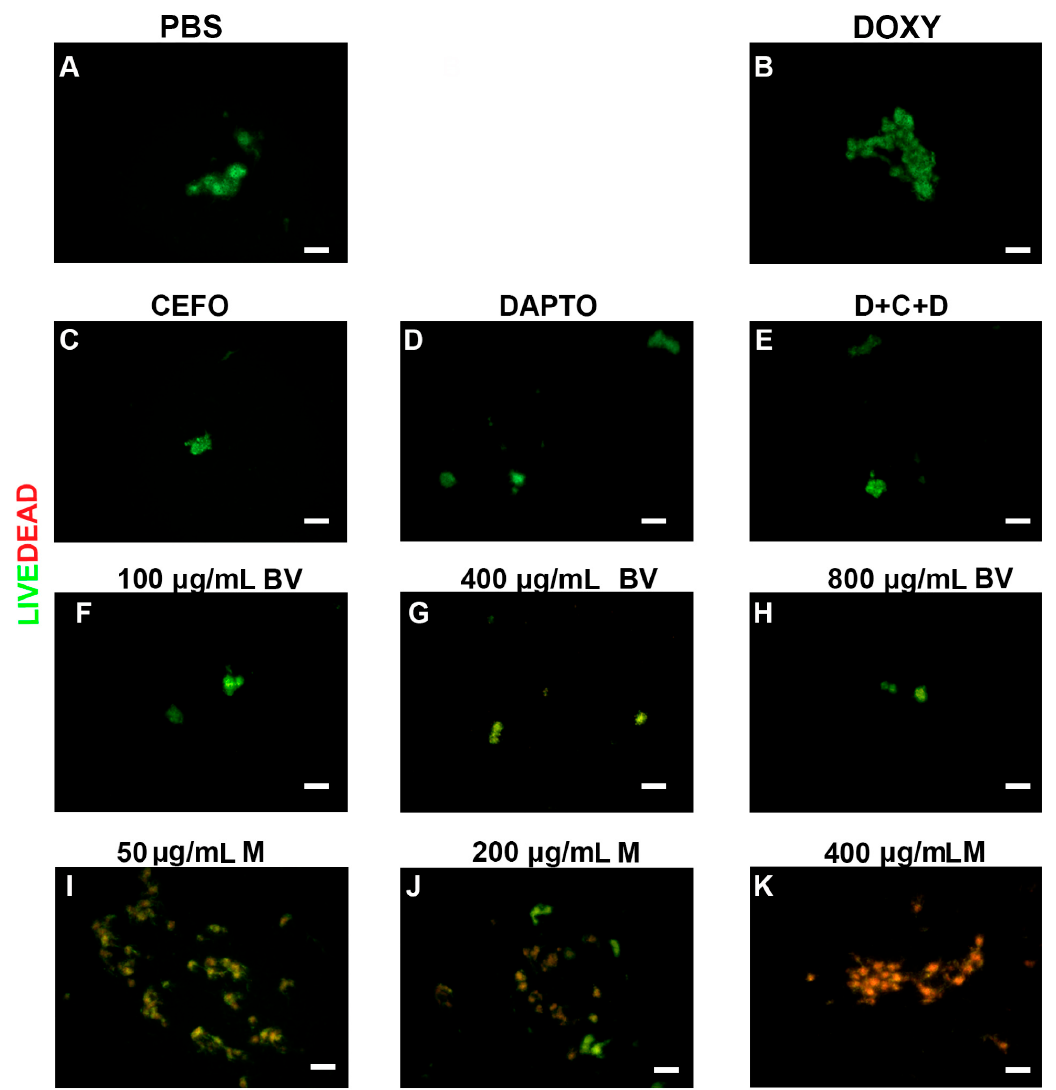
Figure 6. Representative Live/Dead images of the viability of attached Borrelia biofilms following treatment with different antimicrobial agents. Biofilms were stained with SYBR Green I and PI as outlined in the Material and Methods and representative images were taken at 100× magnification. Panel ( A ) Borrelia culture treated only with PBS was used as a negative control. Panel ( B ) Doxycycline (DOXY) treated, Panel ( C ) Cefoperazone (CEFO) treated, Panel ( D ) Daptomycin (DAPTO) treated and Panel ( E ) Three-antibiotic combination (D + C + D). Panels ( F – H ) Bee venom (BV) was used in increasing concentrations while Panels ( I – K ) depict melittin treated cells at different concentration. Live cells are stained with green color while dead cells are stained red. Scale bar: 100 μ m.